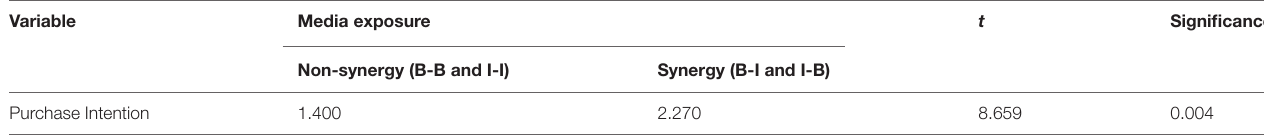
TABLE 2 | Comparison of separate stimulation and synergistic stimulation.